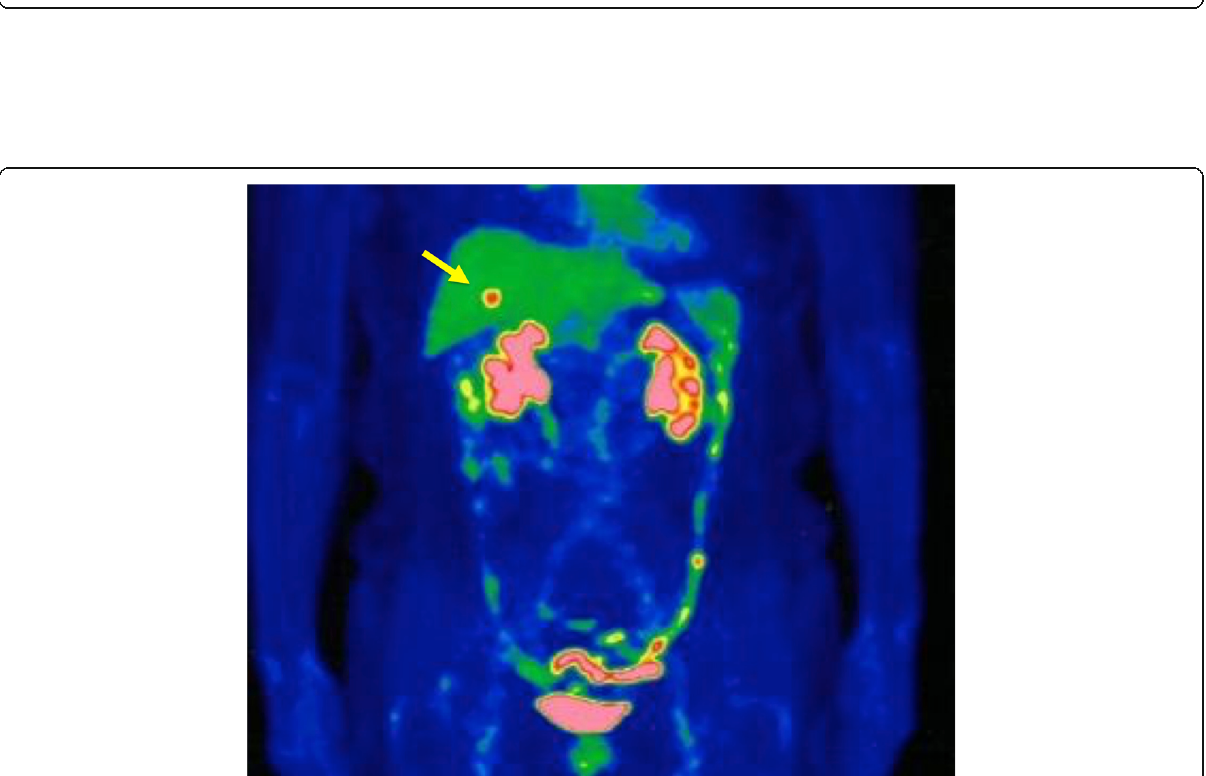
Fig. 4 EUS imaging. Endoscopic ultrasonography demonstrated a solid tumor in the proximal gallbladder that seemed to invade the hepatic parenchyma adjacent to the gallbladder (see the arrows). The dotted line indicates the size of the mass